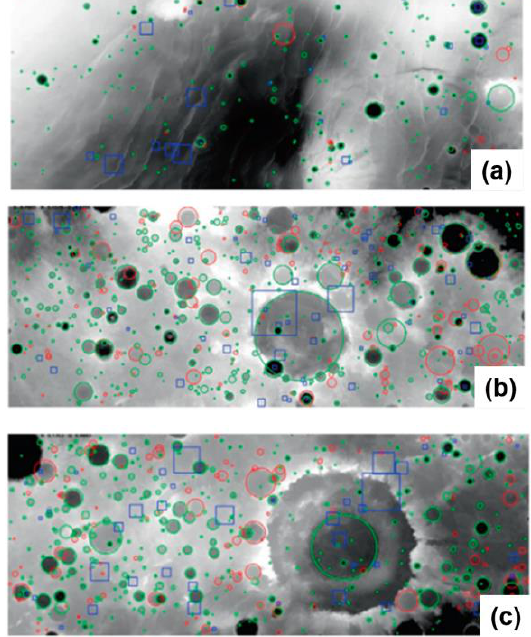
Figure 9. The results of AdaBoost classifiers (( a ): AdaBoost classifier-1; ( b ): AdaBoost classifier-2; ( c ): a: AdaBoost classifier-3. The green circles denote true positive, the red circles denote false negative and the blue boxes denote false positive) (Cited from [30]).